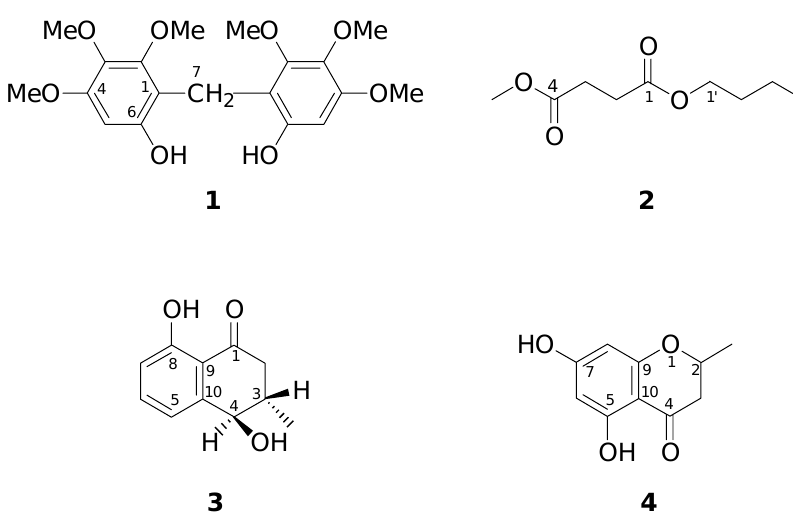
Figure 1. Chemical structures of compounds 1 - 4 .